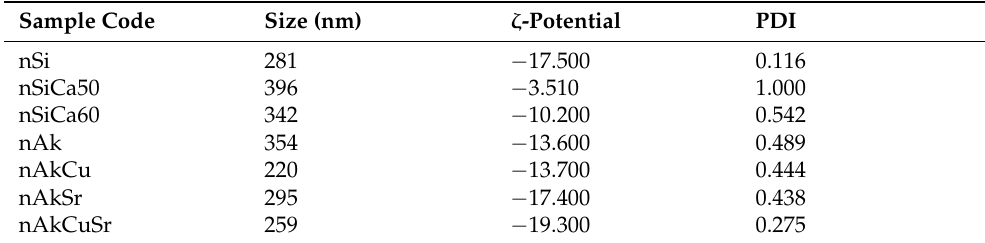
Table 3. Results of ζ -potential